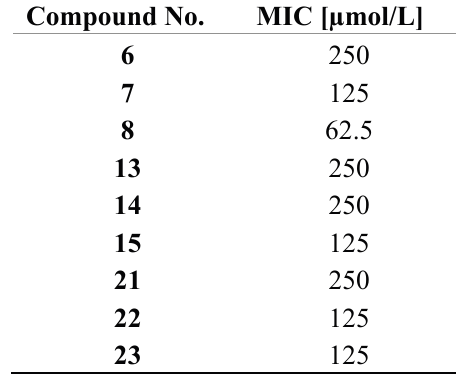
Table 2. Antifungal activity of studied compounds against Trichophyton mentagrophytes . Compound No.